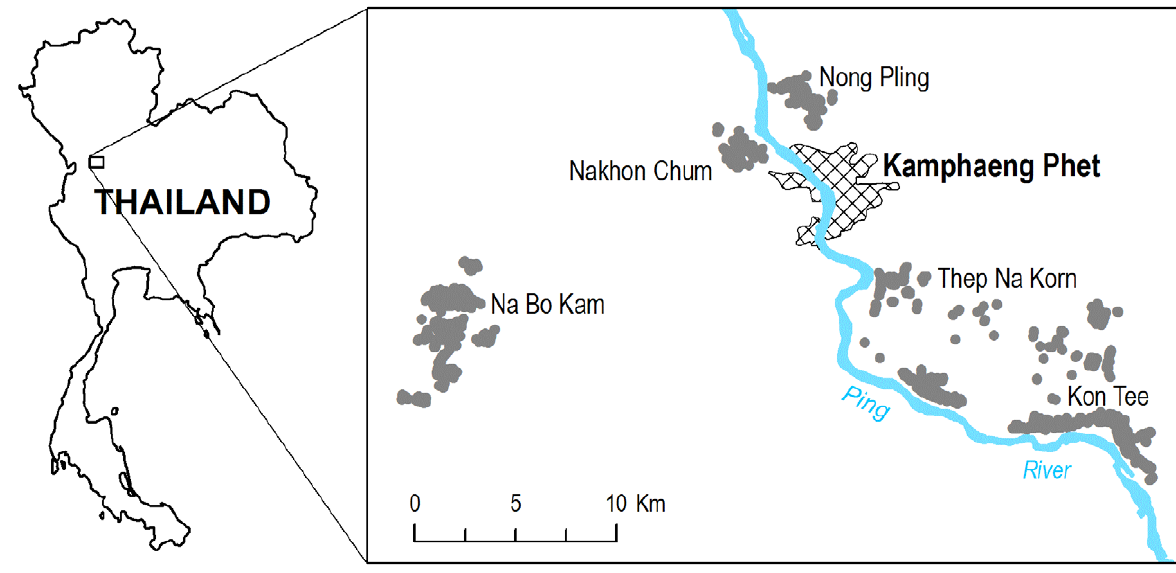
Figure 1. Study area. The gray areas indicate places where homes were mapped for survey in Kon Tee, Na Bo Kam, Thep Na Korn, Nakhon Chum, and Nong Pling sub districts. The cross hatching indicates the urbanized area of the city of Kamphaeng Phet, Thailand.